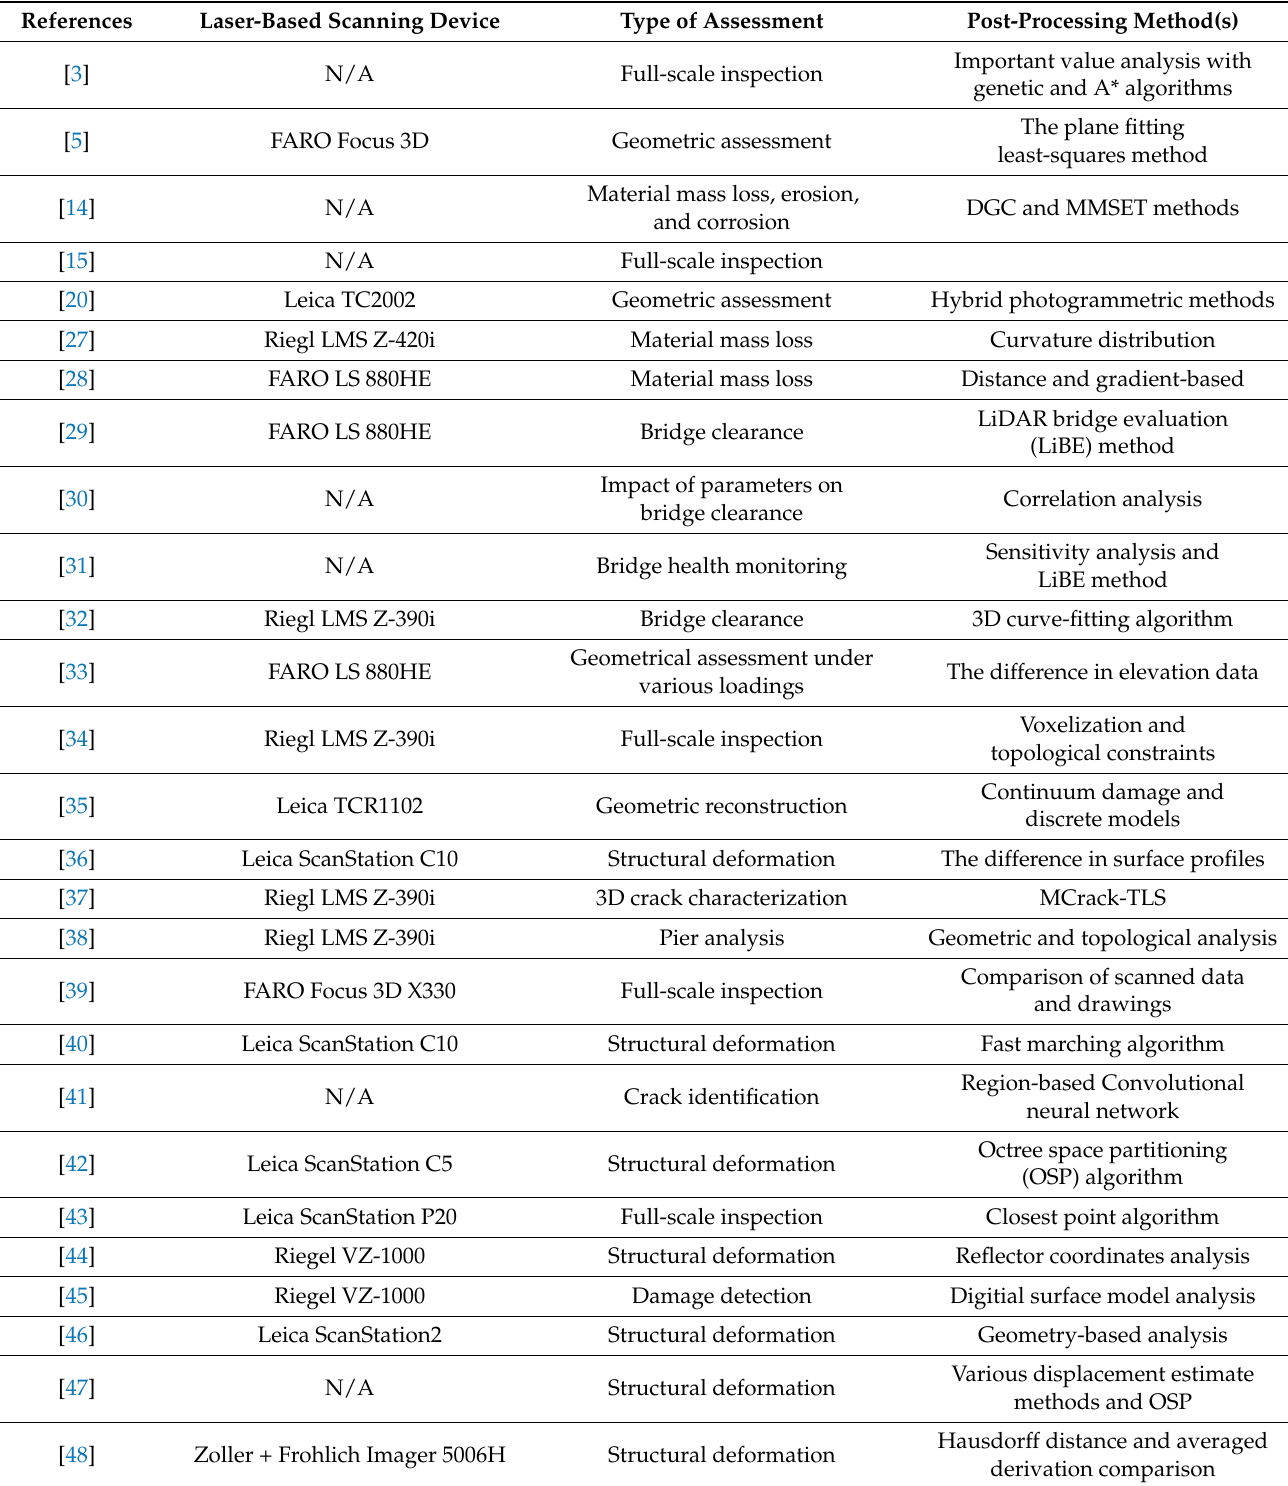
Table 2. A comprehensive summary of laser-based assessment techniques for